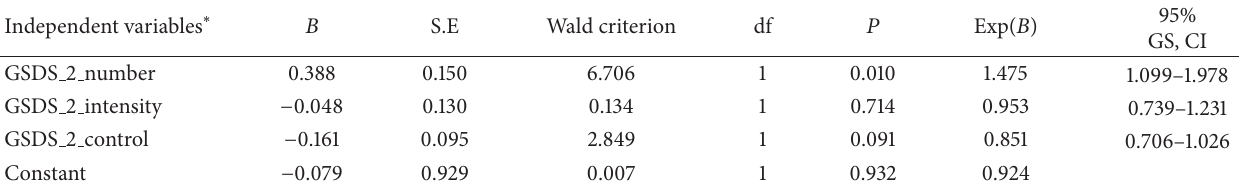
Table 7: Risk of general health conditions affected by distress in seafarers after the treatment.